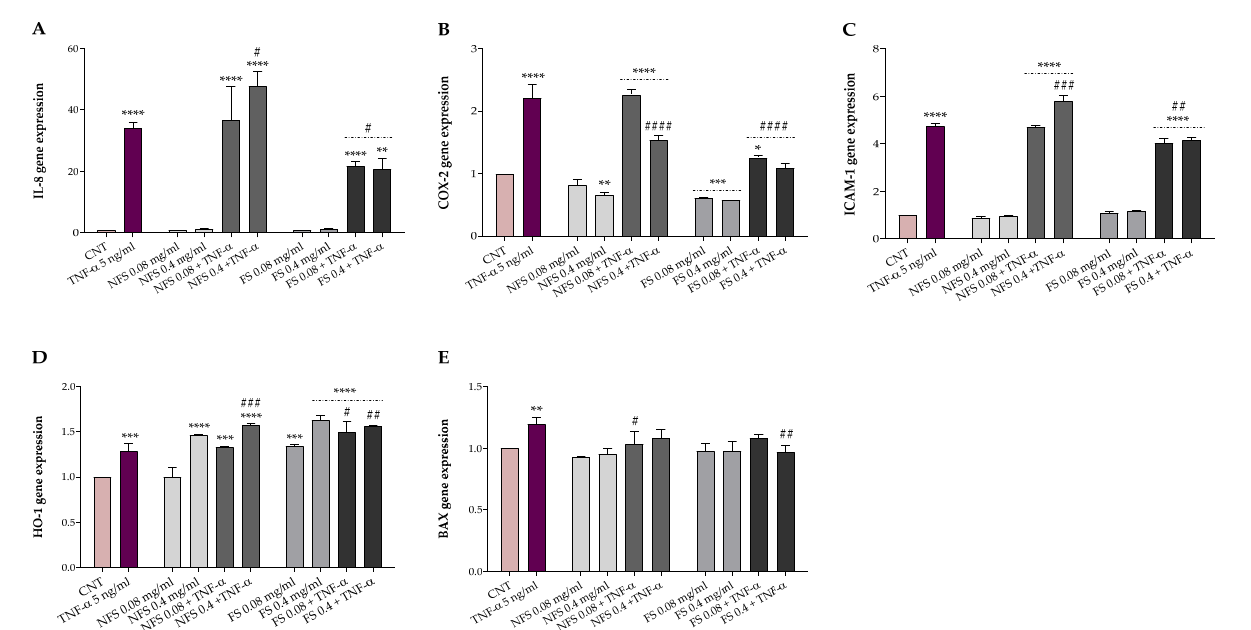
Figure 2. Quantitative Real-Time RT-PCR analysis of IL-8 ( A ), COX-2 ( B ), ICAM-1 ( C ), HO-1 ( D ), and BAX ( E ) gene expression in HT-29 1-h pre-treated with or without 0.08 or 0.4 mg mL − 1 fermented (FS) and non-fermented (NFS) spelt extract, then exposed for 24 h to 5 ng mL − 1 TNF- α . Experiments were carried out in triplicate, and results were expressed as gene expression fold increase with respect to control. One-way ANOVA with Dunnett’s multiple comparison test: * significantly different from control (CNT), * p < 0.05, ** p < 0.01, *** p < 0.001, **** p < 0.001; # significantly different from TNF- α , # p < 0.05, ## p < 0.01, ### p < 0.001, #### p < 0.0001.